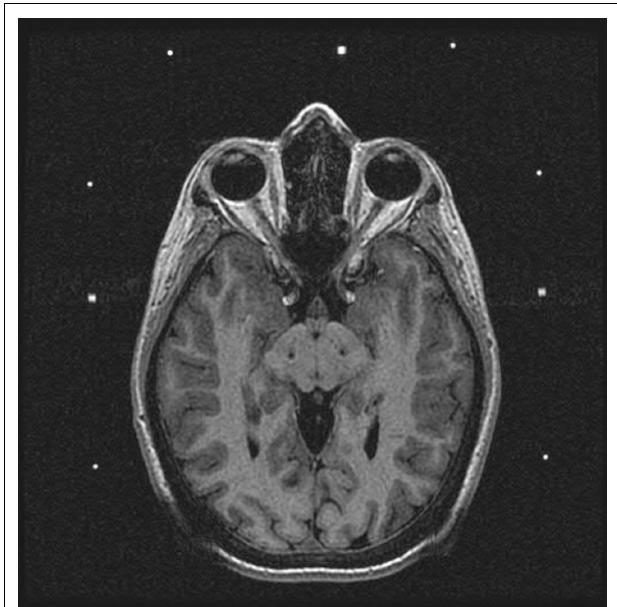
FIGURE 3 | Postoperative MRI demonstrating placement of electrodes in the STN bilaterally for treatment of idiopathic advanced PD.